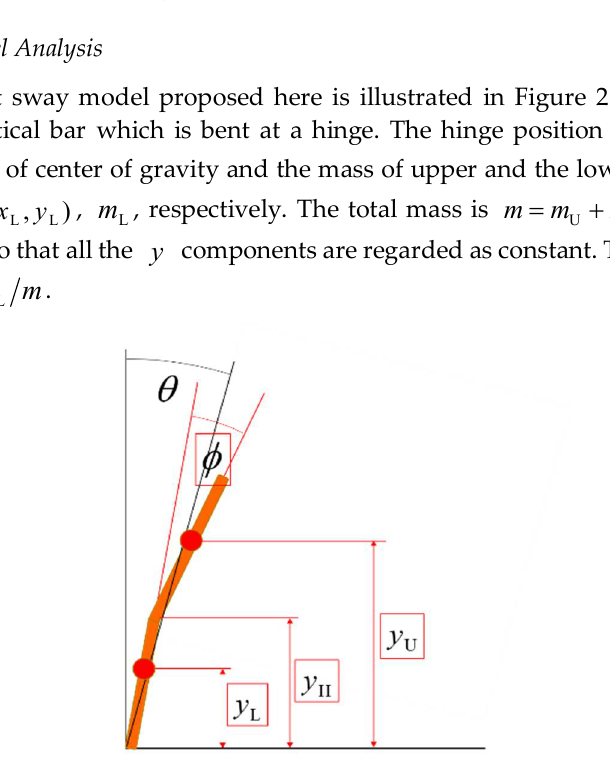
Figure 2. Two-elements Model with Inclination Sway  and Bending Sway 